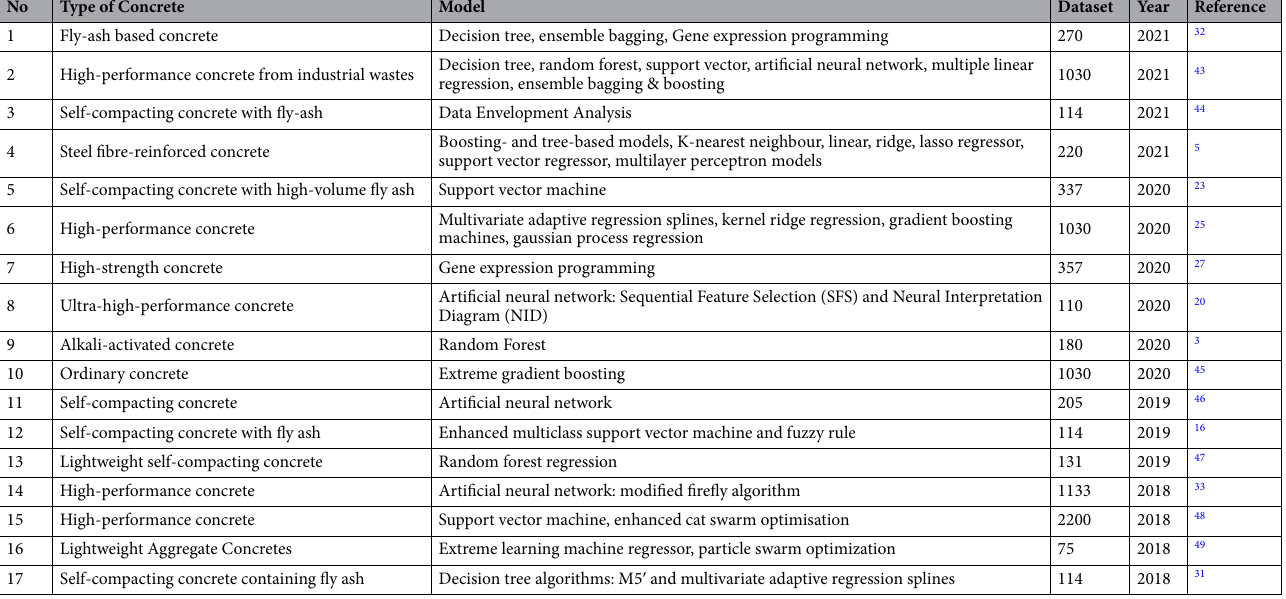
Table 1. Summary of previous studies on concrete strength